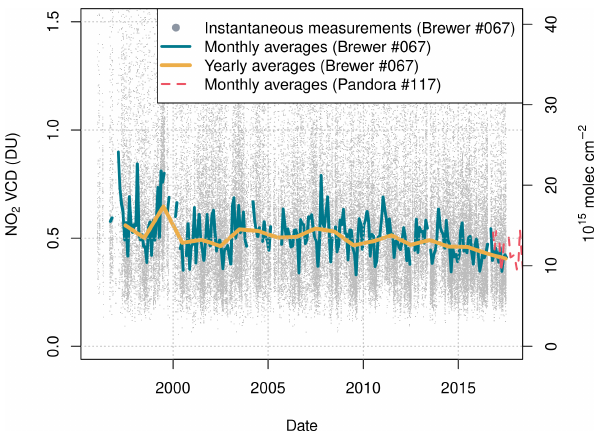
Figure 3. VCDs retrieved using BNALG2 from Brewer #067: in- stantaneous measurements (grey dots) and monthly and yearly av- erages (continuous lines). The monthly averages of the retrievals from Pandora #117 (Sect. 3.4), operating at APL since 2016, are also shown for comparison (dashed